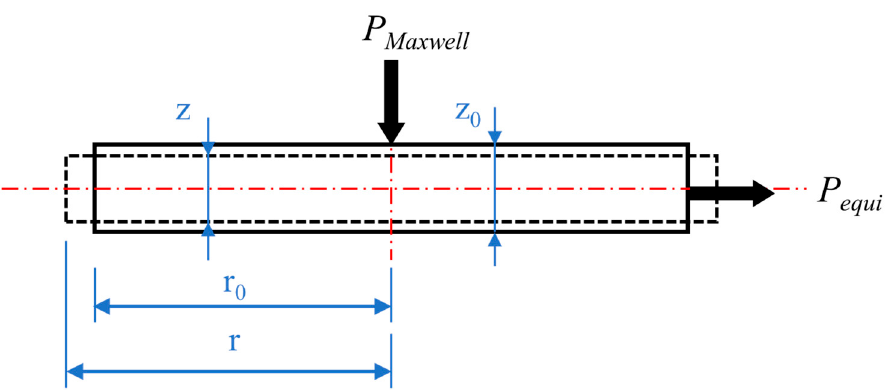
Figure 4. Schematic diagram of the Maxwell stress and equibiaxial stretch force acting on the DE